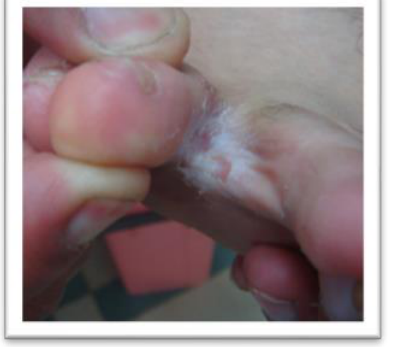
FIGURE 16 : Interdigital type of tinea pedis FIGURE 17: Candida albicans on